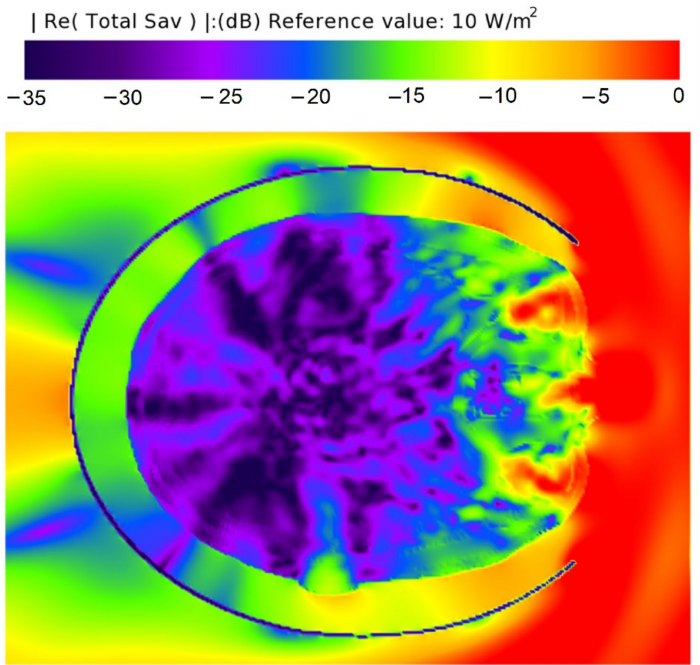
Figure 12. Power density for conductive shield, 3600 MHz (in the logarithmic scale with reference value equal to 10 W/m 2